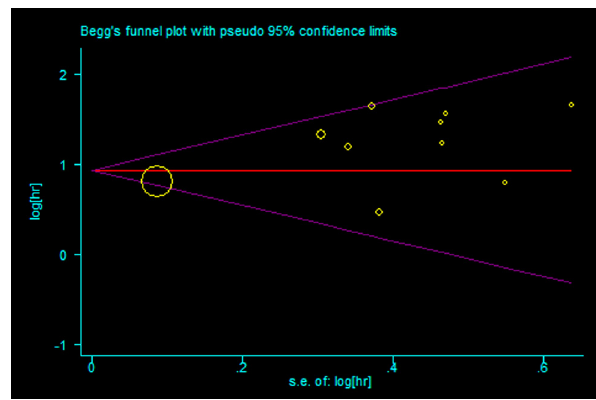
Figure 5: Funnel plot analysis on the detection of the publication bias for the MVD - DFS group. P value of Begg ’ s test for RFS was